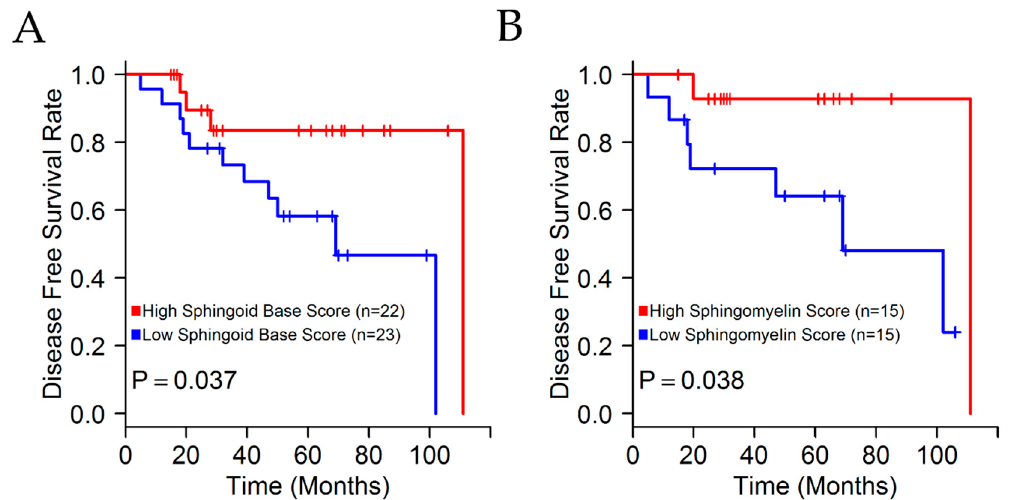
Figure 2. Elevated sphingomyelin levels in primary TNBC samples are prognostic for improved patient survival. ( A ) Kaplan-Meier curves of TNBC patients stratified based on median sphingoid base abundance (log rank test). ( B ) Kaplan-Meier curves of TNBC patients stratified based on highest vs. lowest tertile of sphingomyelin abundance (log rank test).